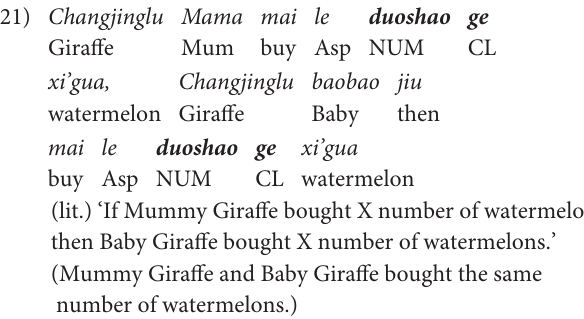
the same structure, comparing the number of other vegetables bought by other two pairs of characters (Mummy Dog and Baby Dog buying sweat potatoes, the boy and the girl buying lemons). The participants were asked to judge separately whether the puppet’s statements were true or